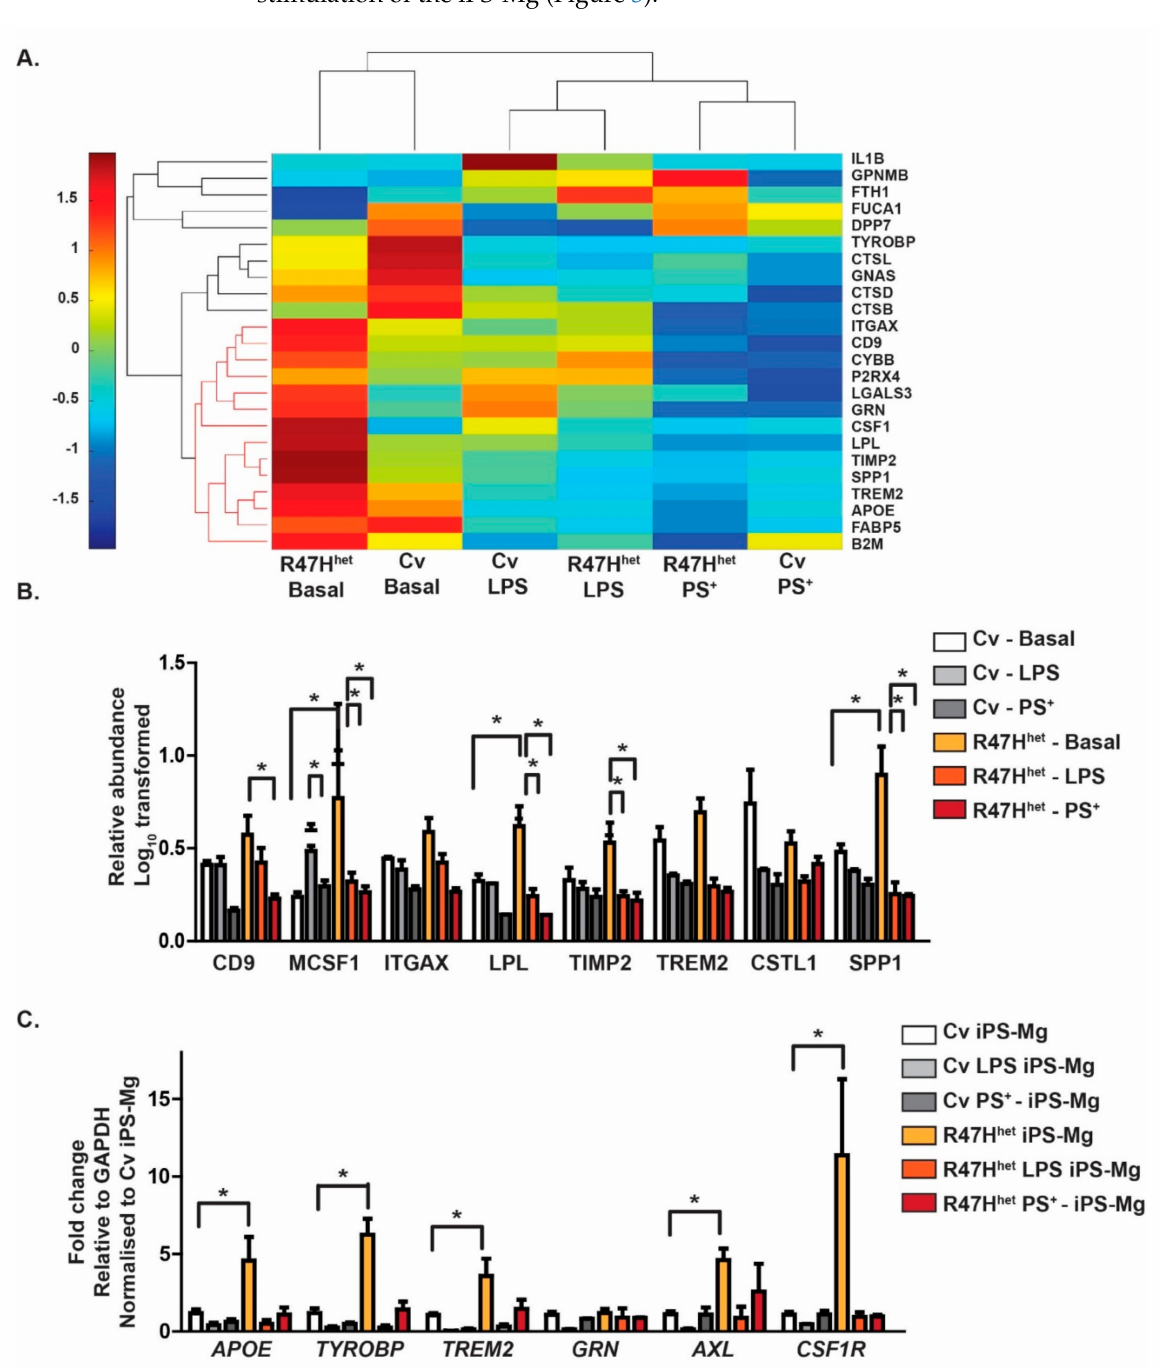
Figure 2. Proteins associated with the DAM microglia signature are found in exosomes. The exosomal proteomic profile was compared with a list of published DAM-related proteins [36–38]. R47H het exosomes contained a subset of DAM-associated proteins (indicated in orange) at higher levels than Cv exosomes ( A ). These proteins were particularly enriched with the TREM2-dependent second stage of DAM [36]. The relative abundance of the DAM proteins in the exosomes was normalised to the abundance observed in Cv exosomes of these second-stage DAM-associated proteins ( B ). The expression of DAM-associated genes was measured in the iPS-Mg using qPCR to assess whether the changes observed in the exosomes reflected differences at the cellular level or in the packaging ( C ). For ( A , B ), N = 3 independent samples analysed through LC-MS/MS for each condition, whilst for ( C ), N = 4 independent experiments. Two-way ANOVA with * p < 0.05, ** p <